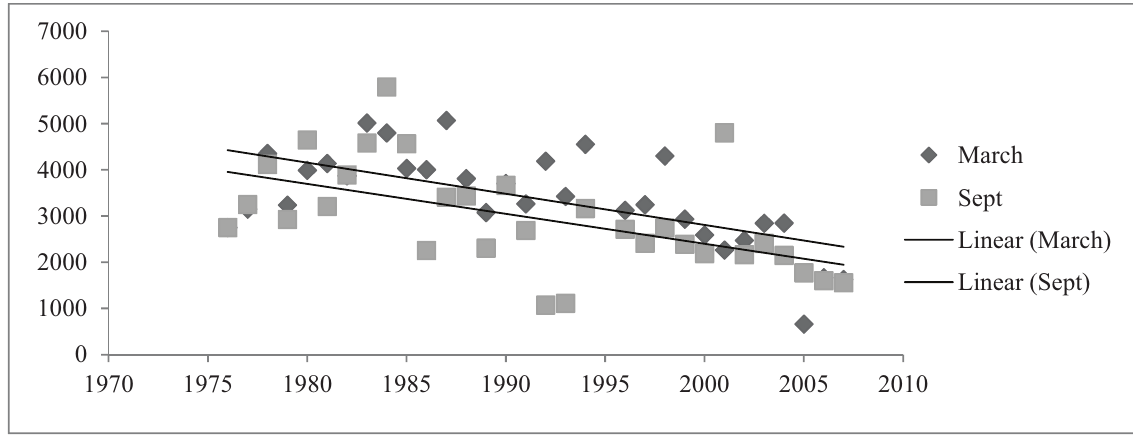
Figure 3. Total Species Abundance in March and September months.